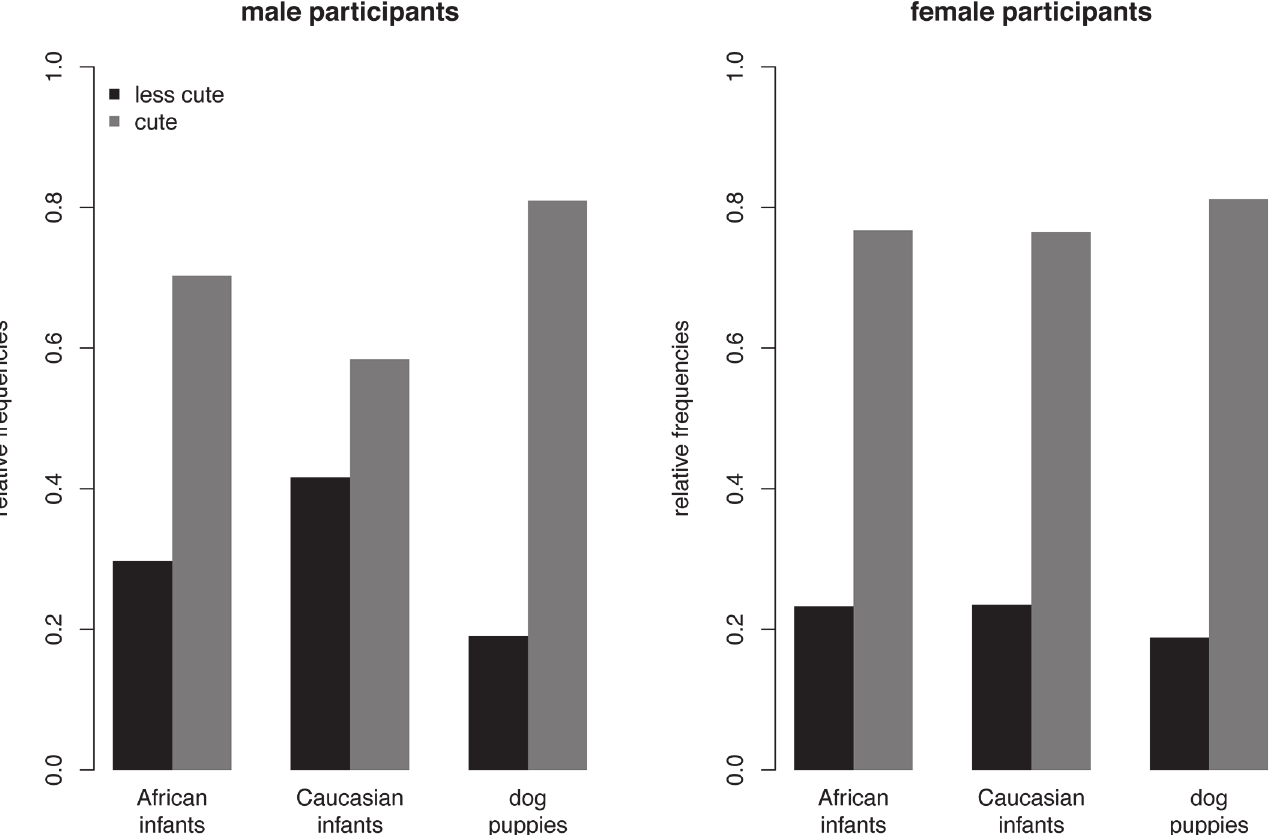
Fig 1. Descriptive statistics of Study 1: Toy-Task. Relative frequencies are presented for cute and less cute faces being chosen for each stimulus category and separately for male and female participants.